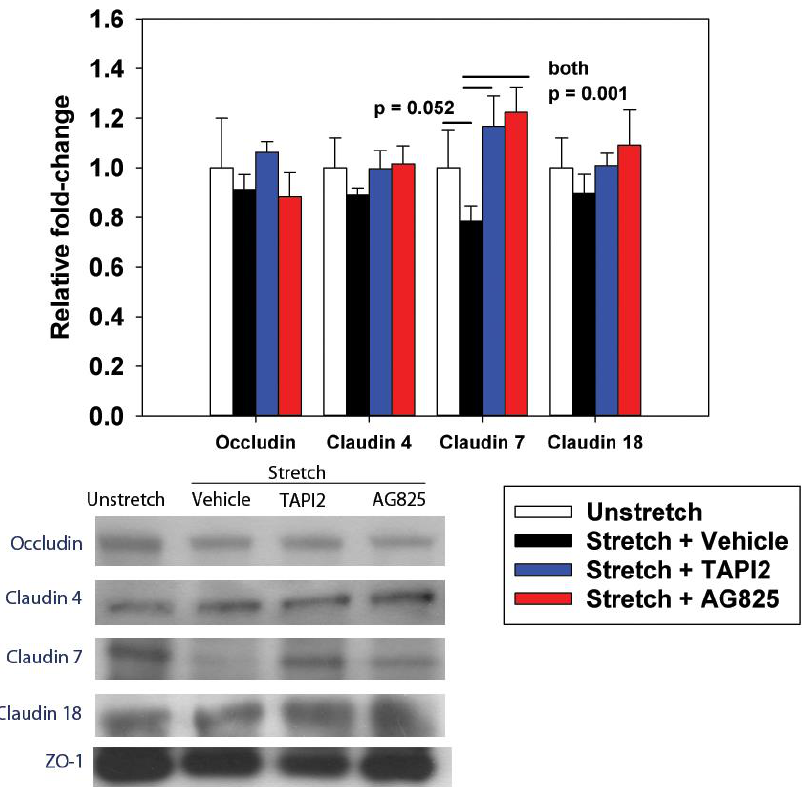
Figure 3. Effect of cyclic stretch (ΔSA 37%, 0.25 Hz, 10 min) and HER pathway inhibition on tight junction protein expression. After IP using ZO-1, proteins were quantified using Western blot analysis for occluding, and claudins-4, 7, and 18. Treatment with TAPI2 (50 µM) and AG825 (50 µM) reversed stretch-induced decreases in claudin-7. Values are normalized to unstretched cells. n = 5; p values represent the result of ANOVA and post-hoc Tukey.